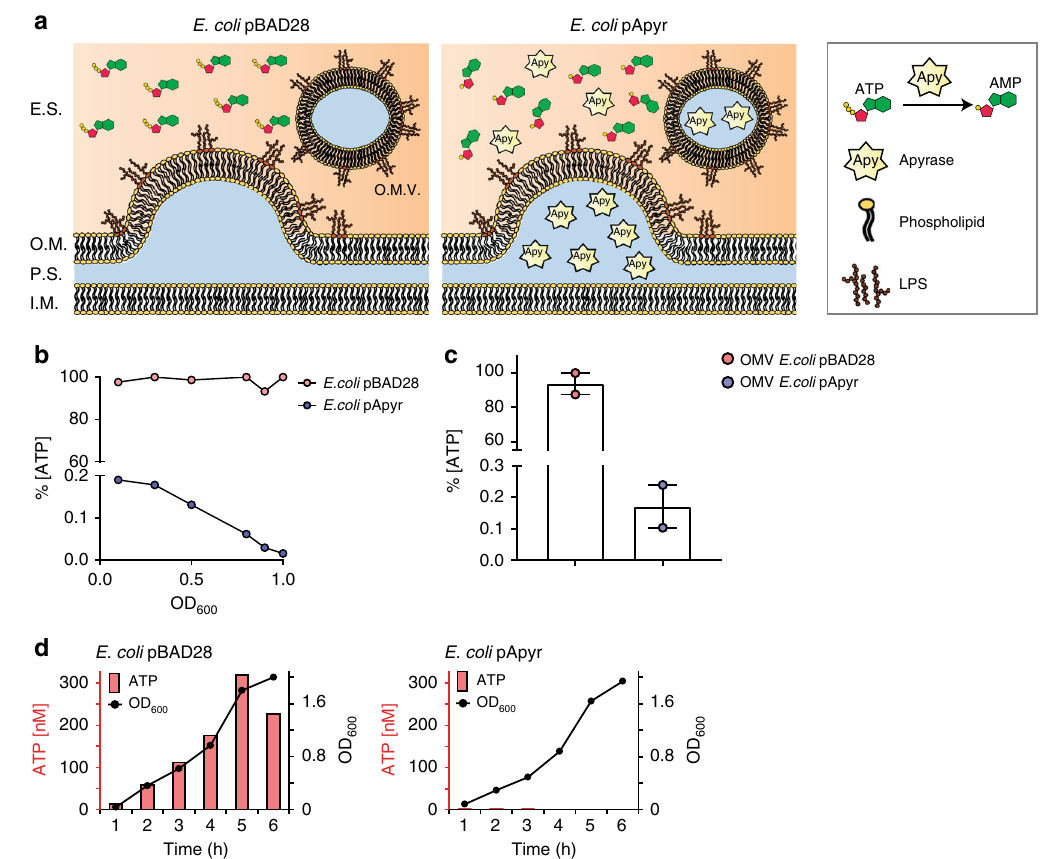
Fig. 2 Apyrase release by E. coli . a Schematic model of apyrase release by E. coli (E.S., extracellular space; O.M., outer membrane; P.S., periplasmic space; I. M., inner membrane; O.M.V., outer membrane vesicle). b Apyrase activity in culture supernatants of the indicated E. coli transformants at different OD 600 expressed as percentage of non-degraded ATP. c Apyrase activity in OMVs isolated from E. coli pBAD28 and E. coli pApyr . d ATP concentrations in culture medium (bars) and bacterial growth (OD 600 ) over time for E. coli pBAD28 (left panel) or E. coli pApyr (right panel). L-arabinose was added at time 0. One representative experiment out of at least three is